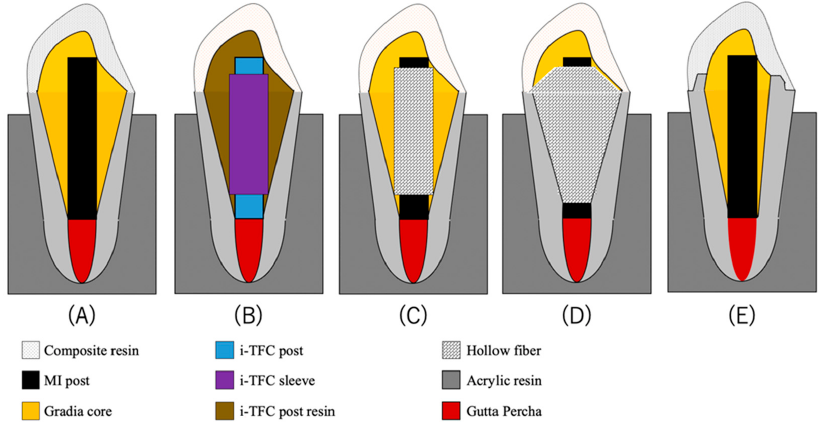
Figure 1. Long axial section of specimens with different restorative techniques (side view). ( A ) MI group, ( B ): i-TFC group, ( C ) Sleeve composite group, ( D ) Custom-made tapered E-glass filling group, ( E ) With ferrule group.